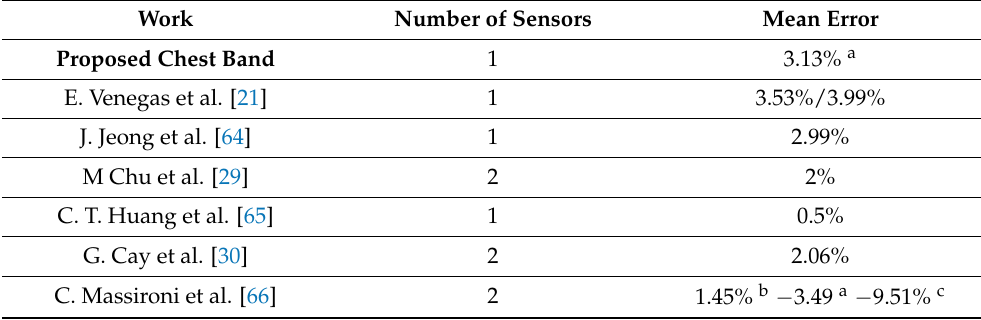
Table 6. Performance comparison of the developed RR monitoring device with other similar systems presented in the scientific